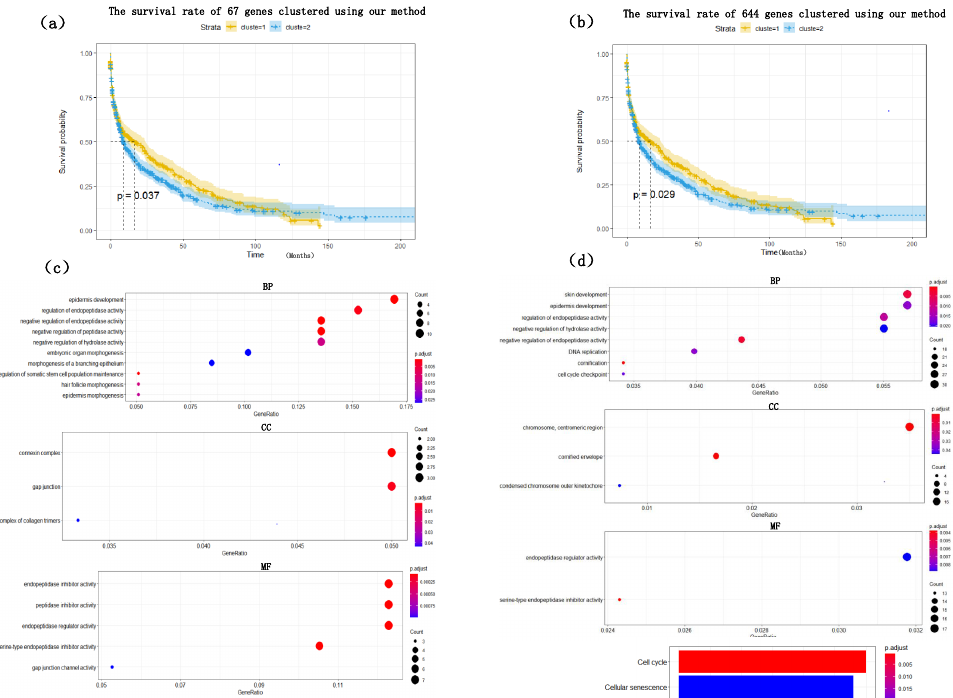
Figure 5. The survival rate and enrichment analysis of 67 genes and 644 selected genes. ( a ) The survival rate schematic of the 67 genes cluster. ( b ) The survival rate schematic of the 644 genes cluster. ( c ) GO enrichment analysis of the 67 genes. ( d) GO enrichment analysis and KEGG pathway enrichment analysis of the 644